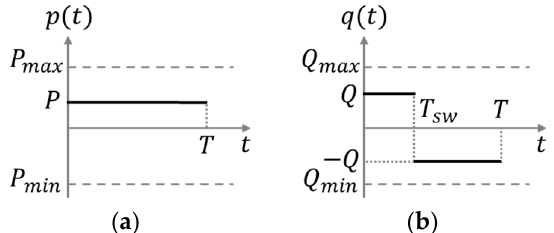
Figure 2. ZMP functions. ( a ) Constant function for sagittal center of mass (COM) motion. ( b ) Step function for lateral COM motion.